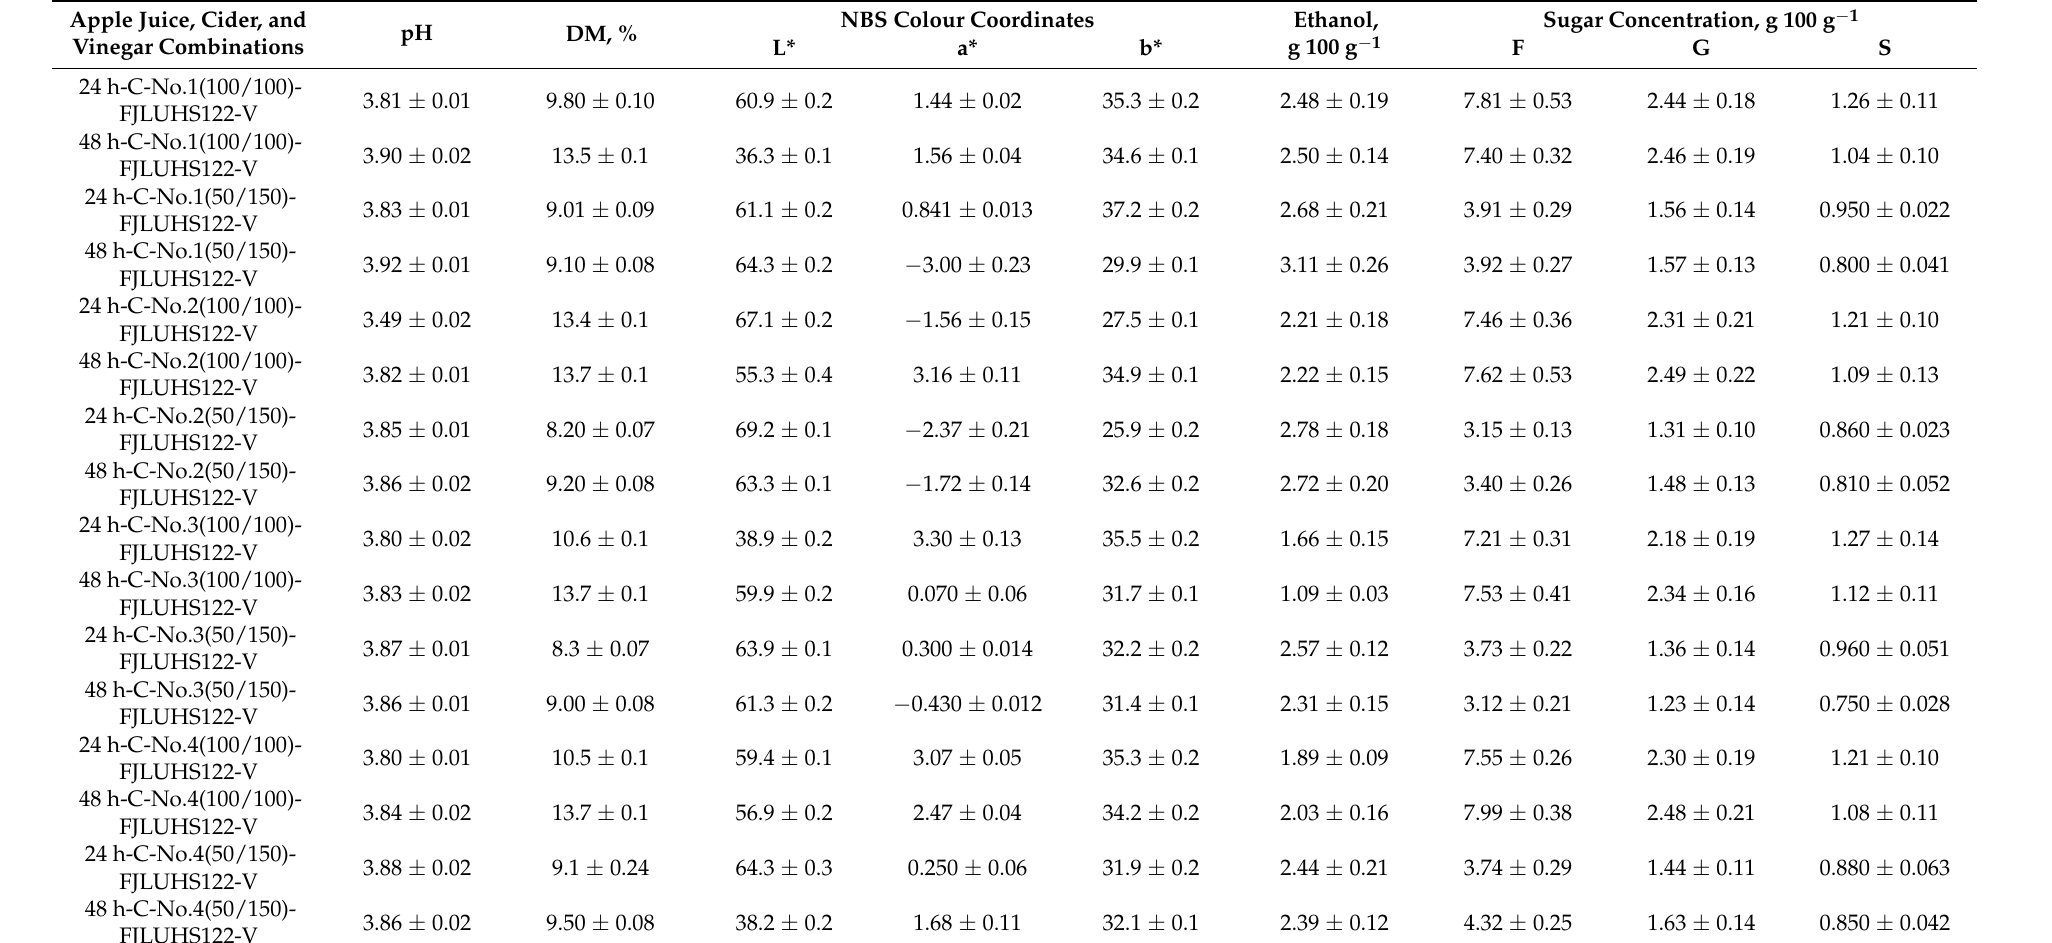
Table 10. Physicochemical parameters of apple juice, cider, and vinegar